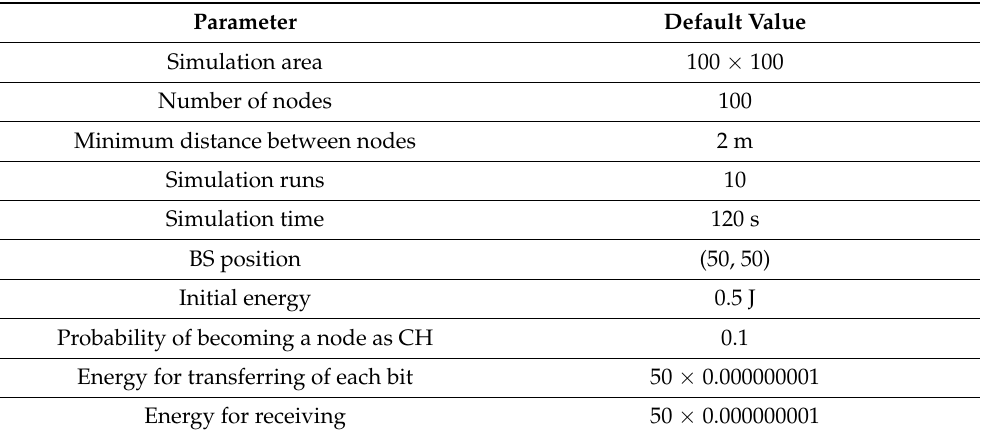
Table 4. Simulation parameters.